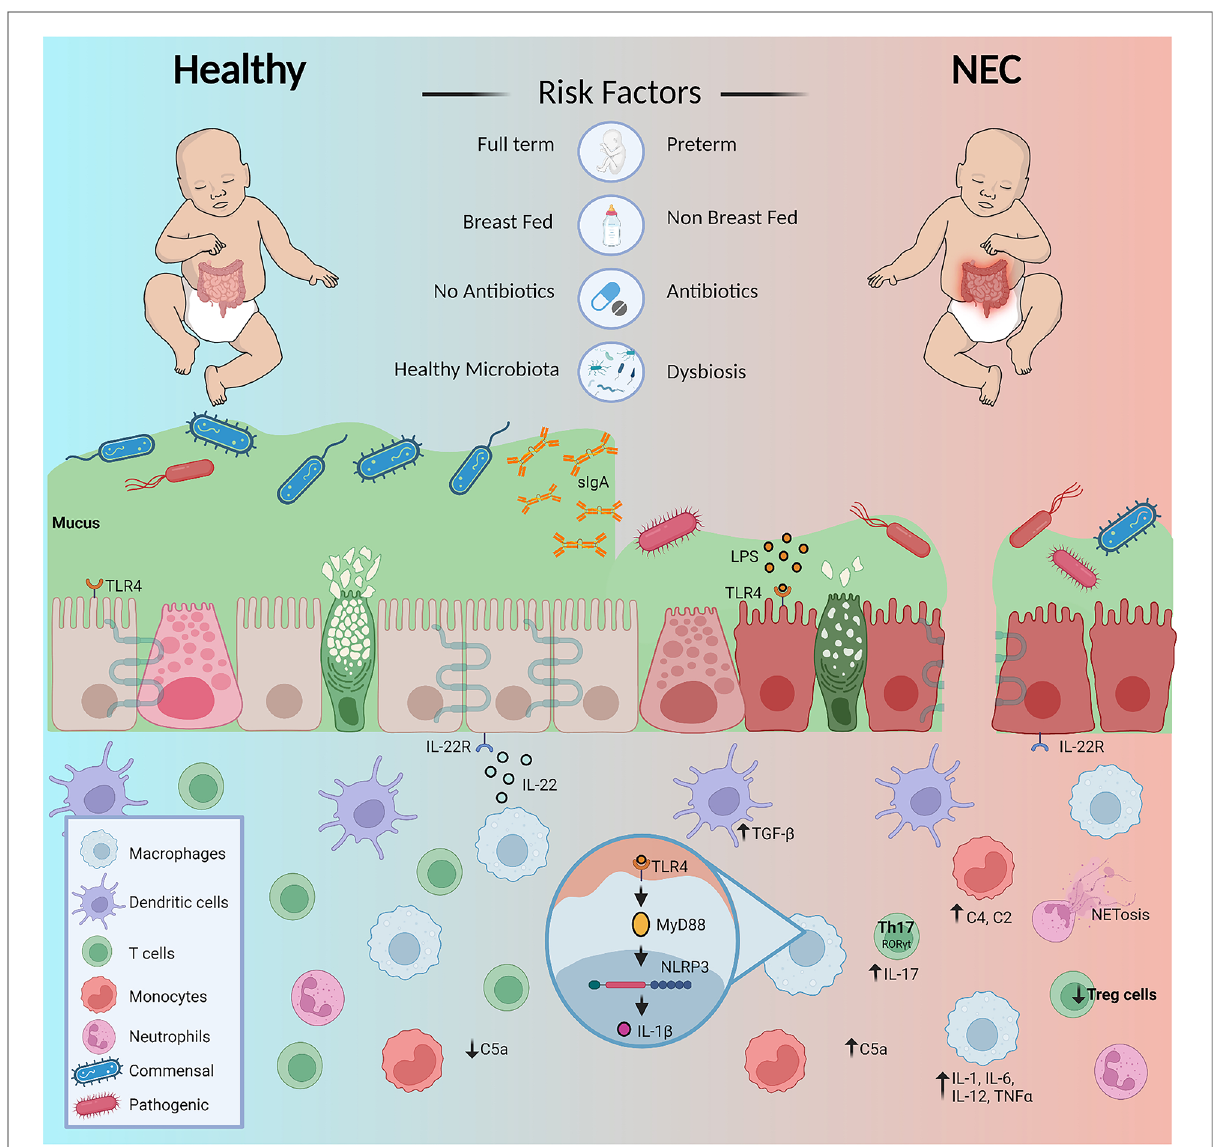
FIGURE 1 Diagrammatic overview of factors predispose premature infants to NEC and dysregulation of immunity contributing to the diseased state. Figure created with Biorender.com and af fi nity